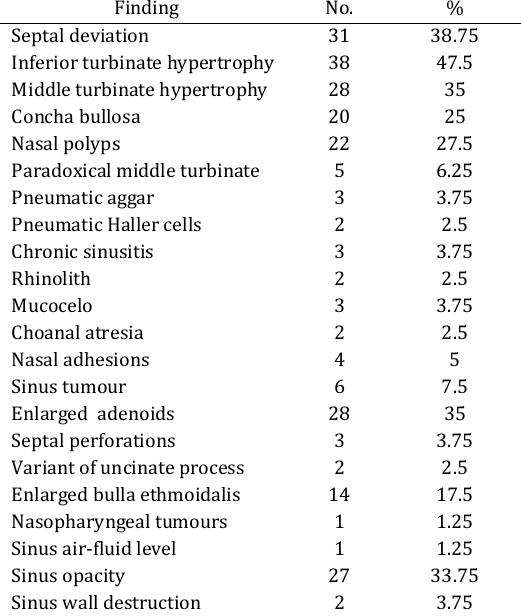
Table 3; Incidence of CT findings